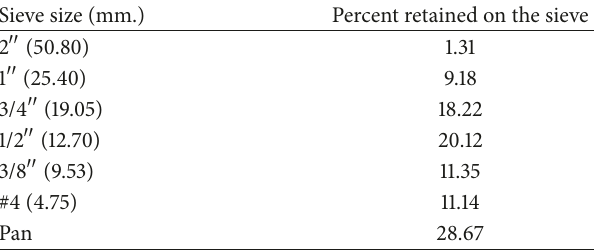
Table 1: Grading of crushed-AAC aggregates.